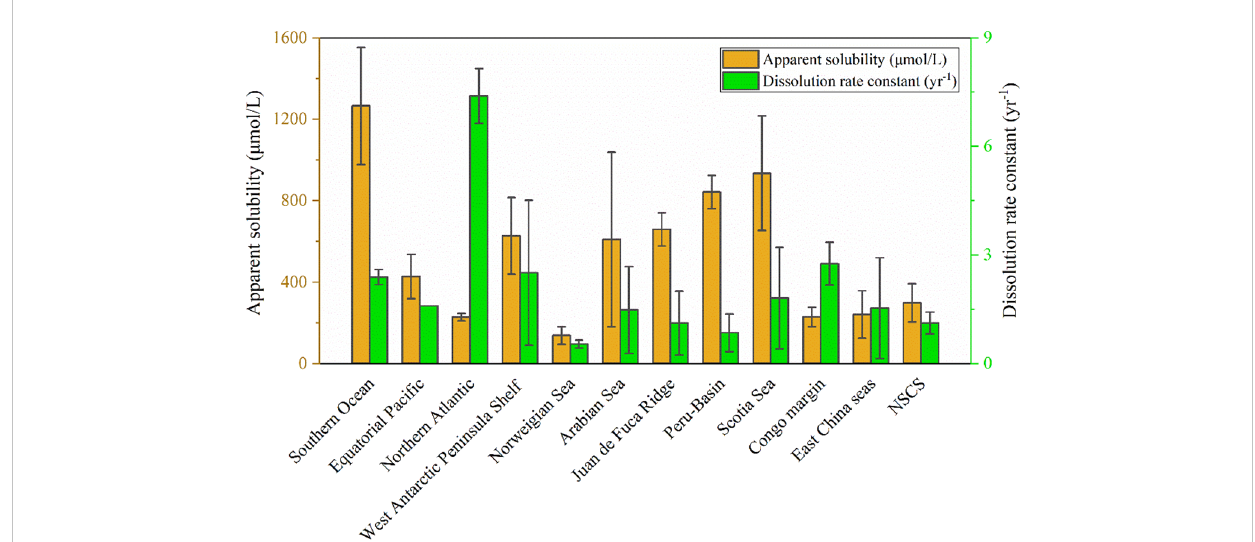
FIGURE 8 The solubilities and dissolution rate constants determined in this study for the NSCS sediments compared with other marginal seas or open oceans, including: the Southern Ocean (Van Cappellen and Qiu, 1997a; Van Cappellen and Qiu, 1997b), the Equatorial Paci fi c (Gallinari et al., 2002), the Northern Atlantic [averaged data from Gallinari et al. (2002); Gallinari et al. (2008) and Ragueneau et al. (2001)], the West Antarctic Peninsula Shelf (Gallinari et al., 2008), the Norweigian Sea (Rickert, 2000), the Arabian Sea (Rickert, 2000), the Juan de Fuca Ridge (Rickert, 2000), the Peru-Basin (Rickert, 2000), the Scotia Sea (Rickert, 2000), the Congo margin (Ragueneau et al., 2009), and east China seas (containing the Yellow Sea and the East China Sea) (Wu et al., 2017; Wu and Liu, 2020). Note that all the dissolution rate constants have been recalculated at 25°C using Eq. (4) for the purpose of